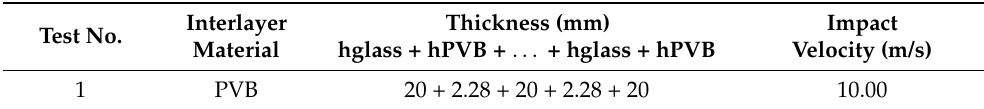
Table 1. Thicknesses of individual laminated glass panel layers.